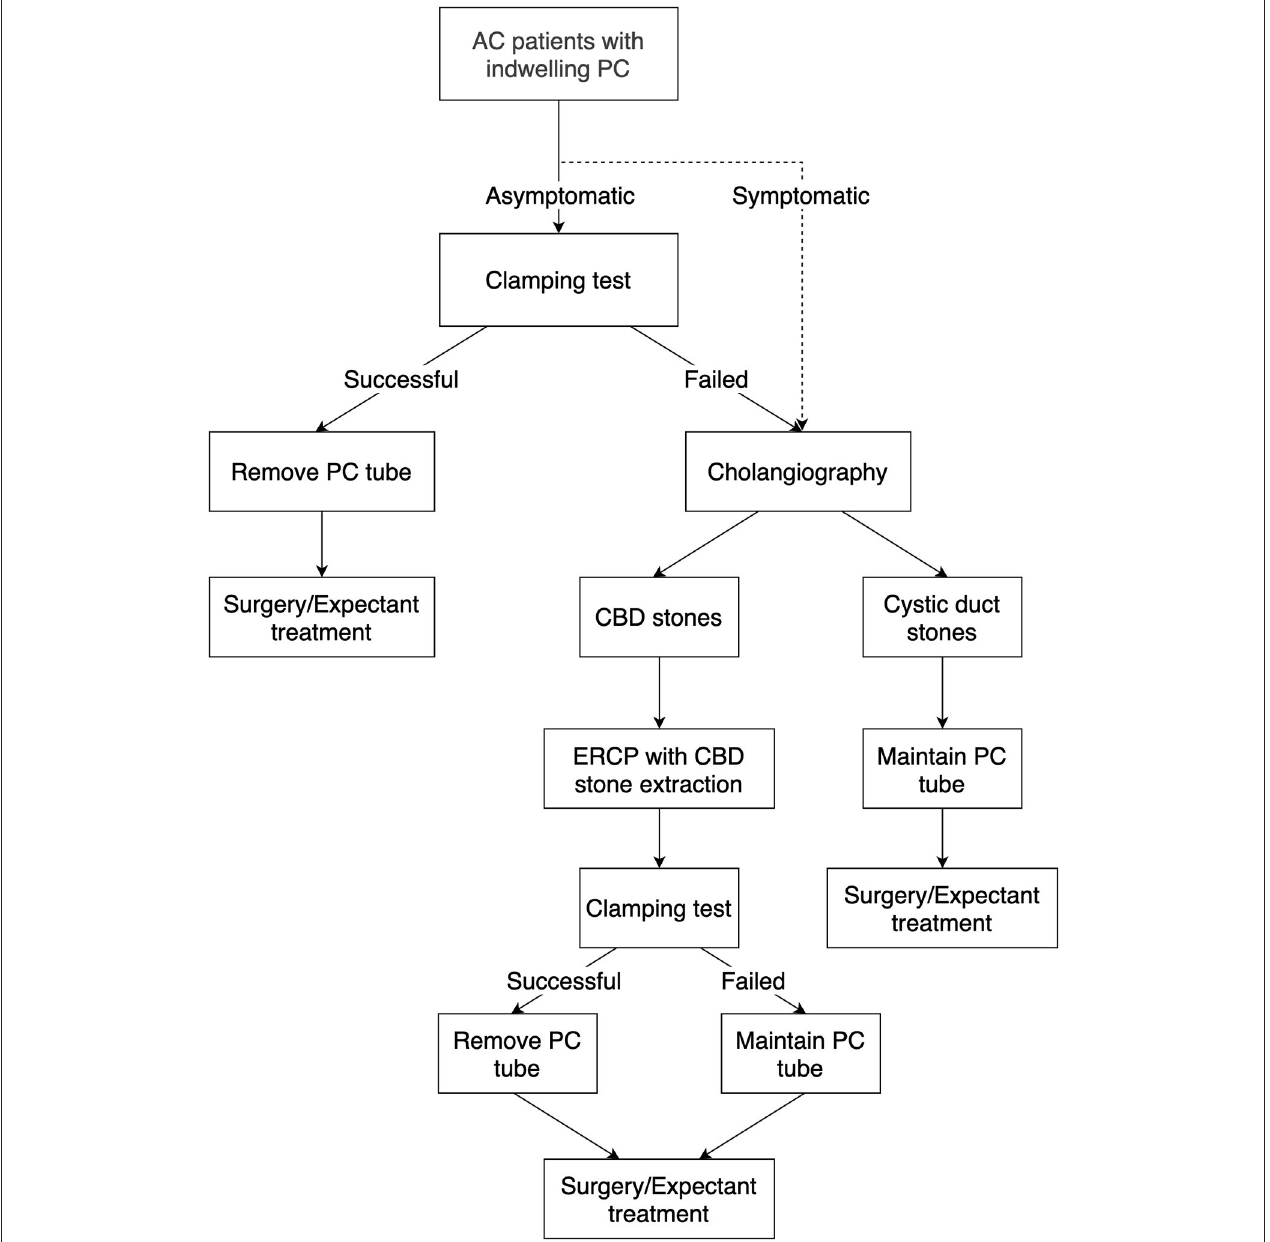
FIGURE 2 | Proposed management algorithm for AC patients following PC placement.